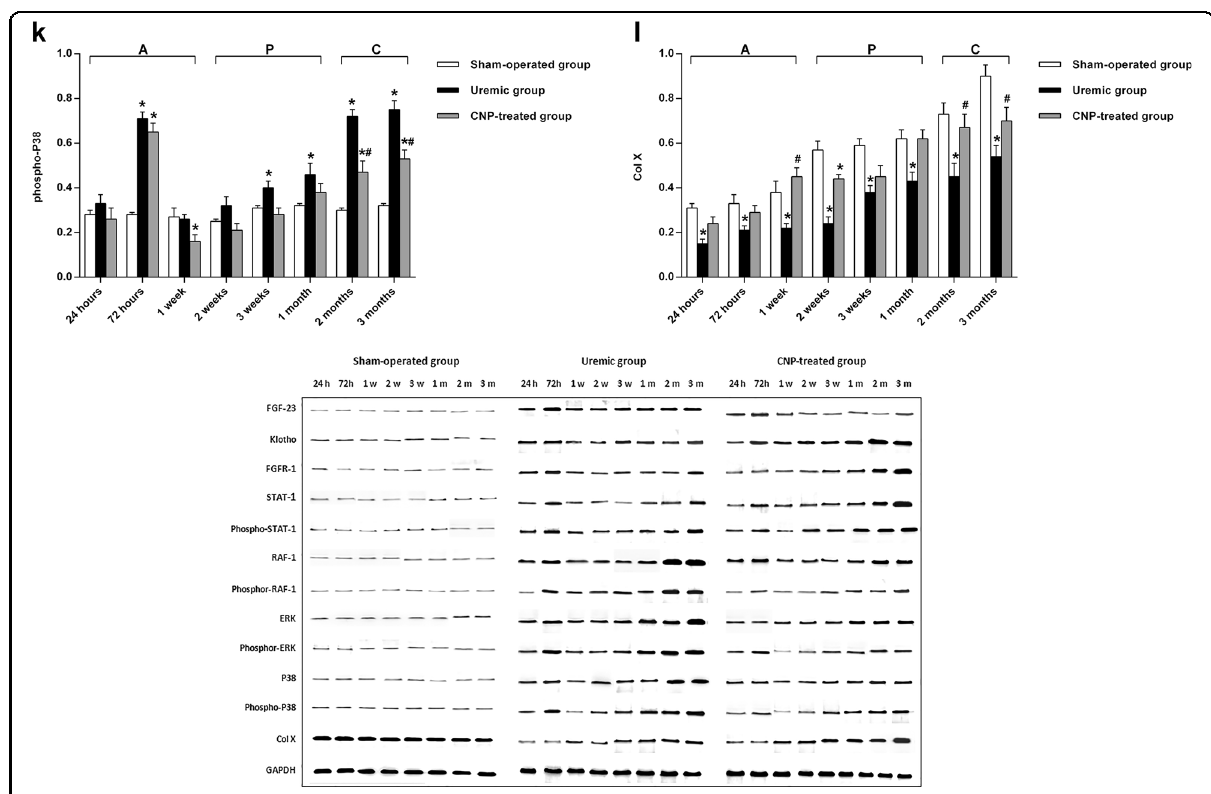
(see fi gure on previous page) Fig. 8 Western blotting to identify bone FGF-23, Klotho, FGFR-1, STAT-1, phosphor-STAT-1, RAF-1, phosphor-RAF-1, ERK, phosphor-ERK, P38, phosphor-P38, Col X, and GAPDH protein in sham-operated, uremic, and CNP-treated rats. Uremic group vs. sham-operated group: The uremic group experienced marked increases in FGF-23, FGFR-1, STAT-1, phospho-STAT-1, RAF-1, phospho-RAF-1, ERK, phospho-ERK, p38, and phospho-P38 protein in each stage ( a , c – k ); CNP-treated rats had higher Klotho protein levels in both the acute stage and chronic stage ( b ); the expression of Col X protein was signi fi cantly suppressed in the uremic group throughout the observational period ( l ). CNP-treated group vs. uremic group: CNP signi fi cantly reduced the expression of the FGF-23 protein in the chronic stage ( a ); CNP administration triggered signi fi cant elevations in Klotho, FGFR-1, and STAT-1 protein levels only in the chronic stage ( b – d ), upregulation of the phospho-STAT-1 protein level after the progressive stage ( e ), and overexpression of the Col X protein level in the acute stage and chronic stage ( l ), whereas RAF-1 and P38 protein levels were signi fi cantly suppressed by CNP throughout the observational period ( f , j ); The CNP-treated group showed signi fi cant reductions in phospho-RAF-1, phospho-ERK, and phospho-P38 protein levels in the chronic stage ( g , i , k ); CNP signi fi cantly downregulated the ERK protein level in both the acute stage and chronic stage ( h ). CNP-treated group vs. sham-operated group : In the CNP-treated group, the expression levels of FGF-23, Klotho, FGFR-1, STAT-1, phospho-STAT-1, RAF-1, phospho-RAF-1, phospho-ERK, ERK, and P38 were signi fi cantly higher than those in the sham-operated group in every stage ( a – j ); the phospho-P38 level was signi fi cantly elevated in the acute stage and chronic stage ( k ); the Col X level signi fi cantly decreased at 2 weeks postoperatively and was at a level similar to that in the sham-operated group after 3 weeks postoperatively ( l ). * P < 0.05, signi fi cantly different from the corresponding sham-operated group; # P < 0.05, signi fi cantly different from the corresponding uremic group. A acute stage, P